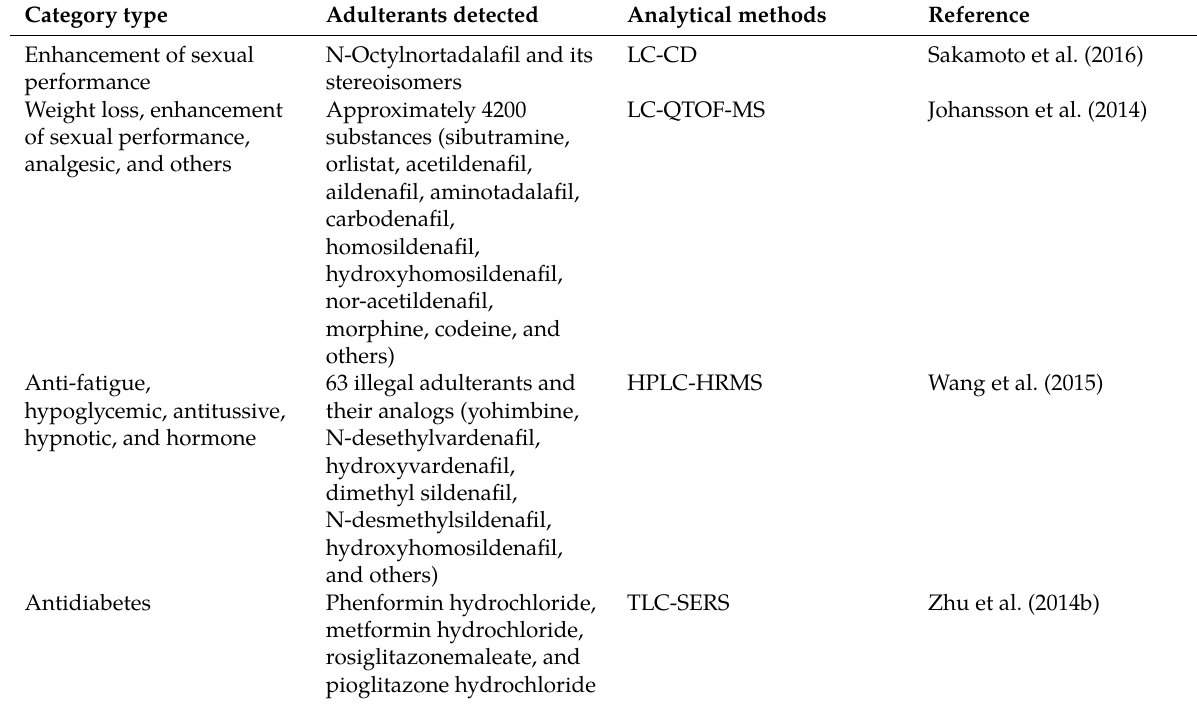
Table 2: Summary of chromatographic and hyphenated analytical approaches used for analysis of adulterant pharmaceu- tical chemicals in botanical dietary